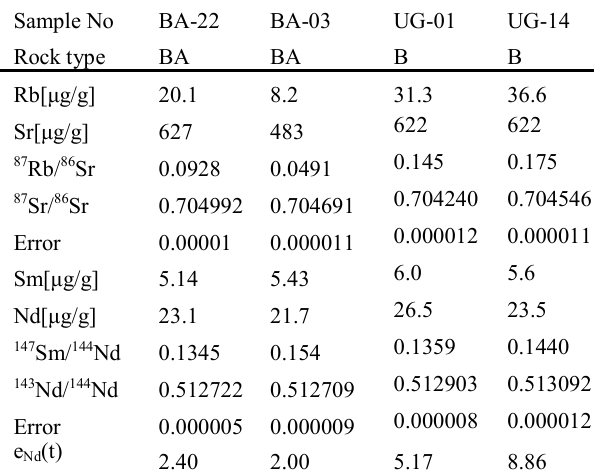
Table 3. Sr-Nd isotopes results of the late Cretaceous- early Cenozoic volcanic